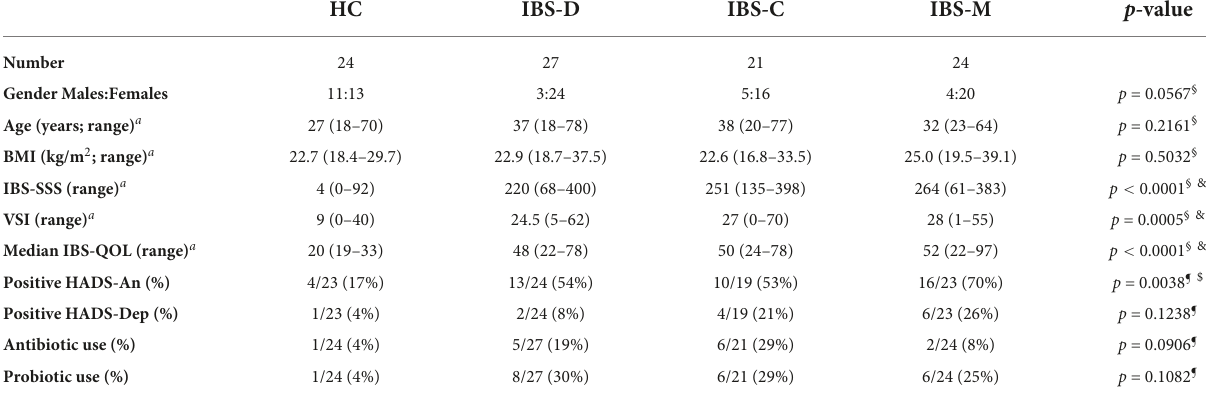
TABLE 2 Baseline